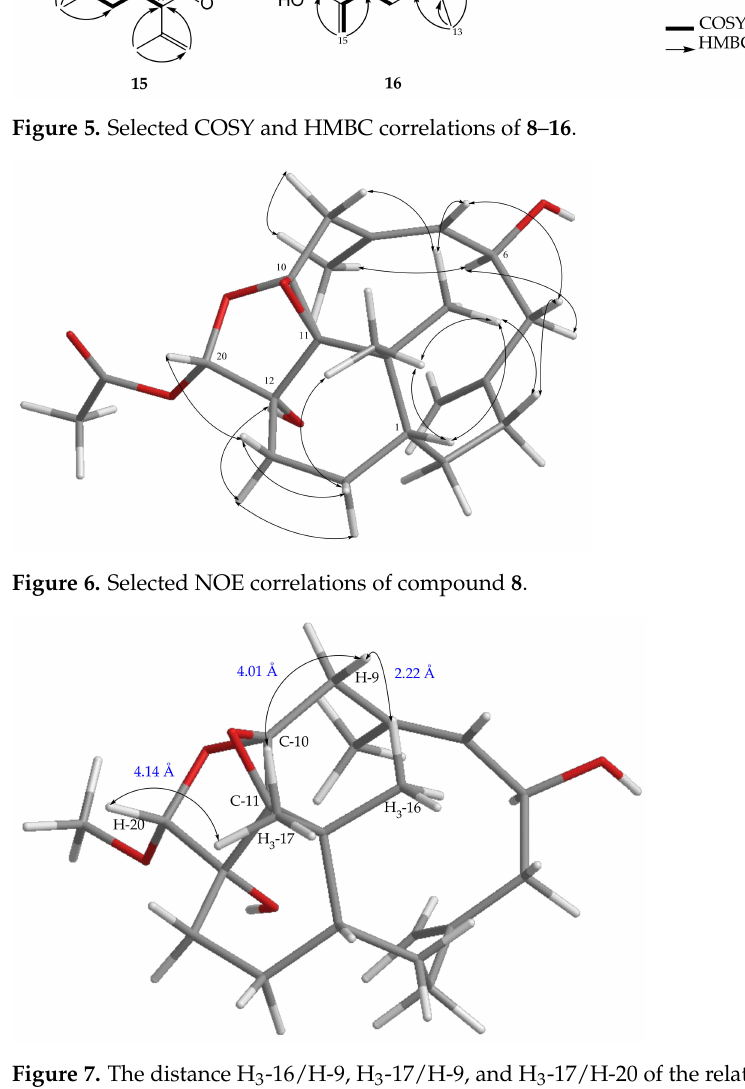
Figure 7. The distance H 3 -16/H-9, H 3 -17/H-9, and H 3 -17/H-20 of the relative configuration of C-10 and C-11 in compound 5